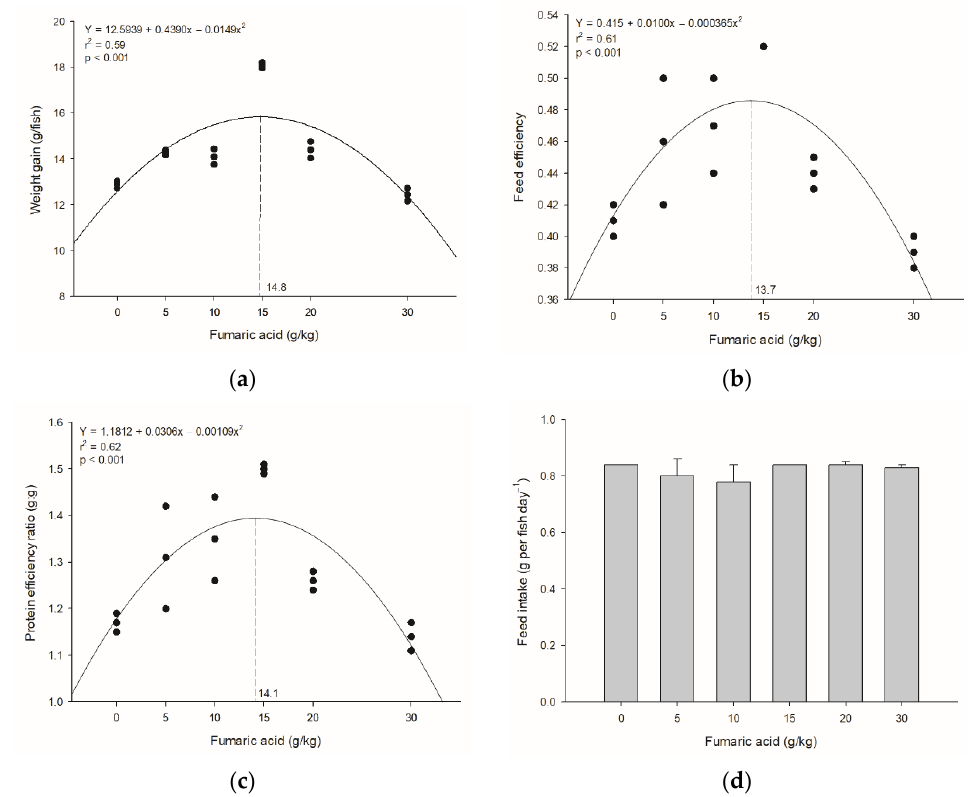
Figure 1. Relationship between productive performance parameters of Nile tilapia juveniles and dietary fumaric acid levels after 35 days: ( a ) weight gain; ( b ) feed efficiency ratio; ( c ) protein efficiency ratio and ( d ) feed intake. The dashed line indicates the level of fumaric acid supplementation in Nile tilapia diets for maximum response.